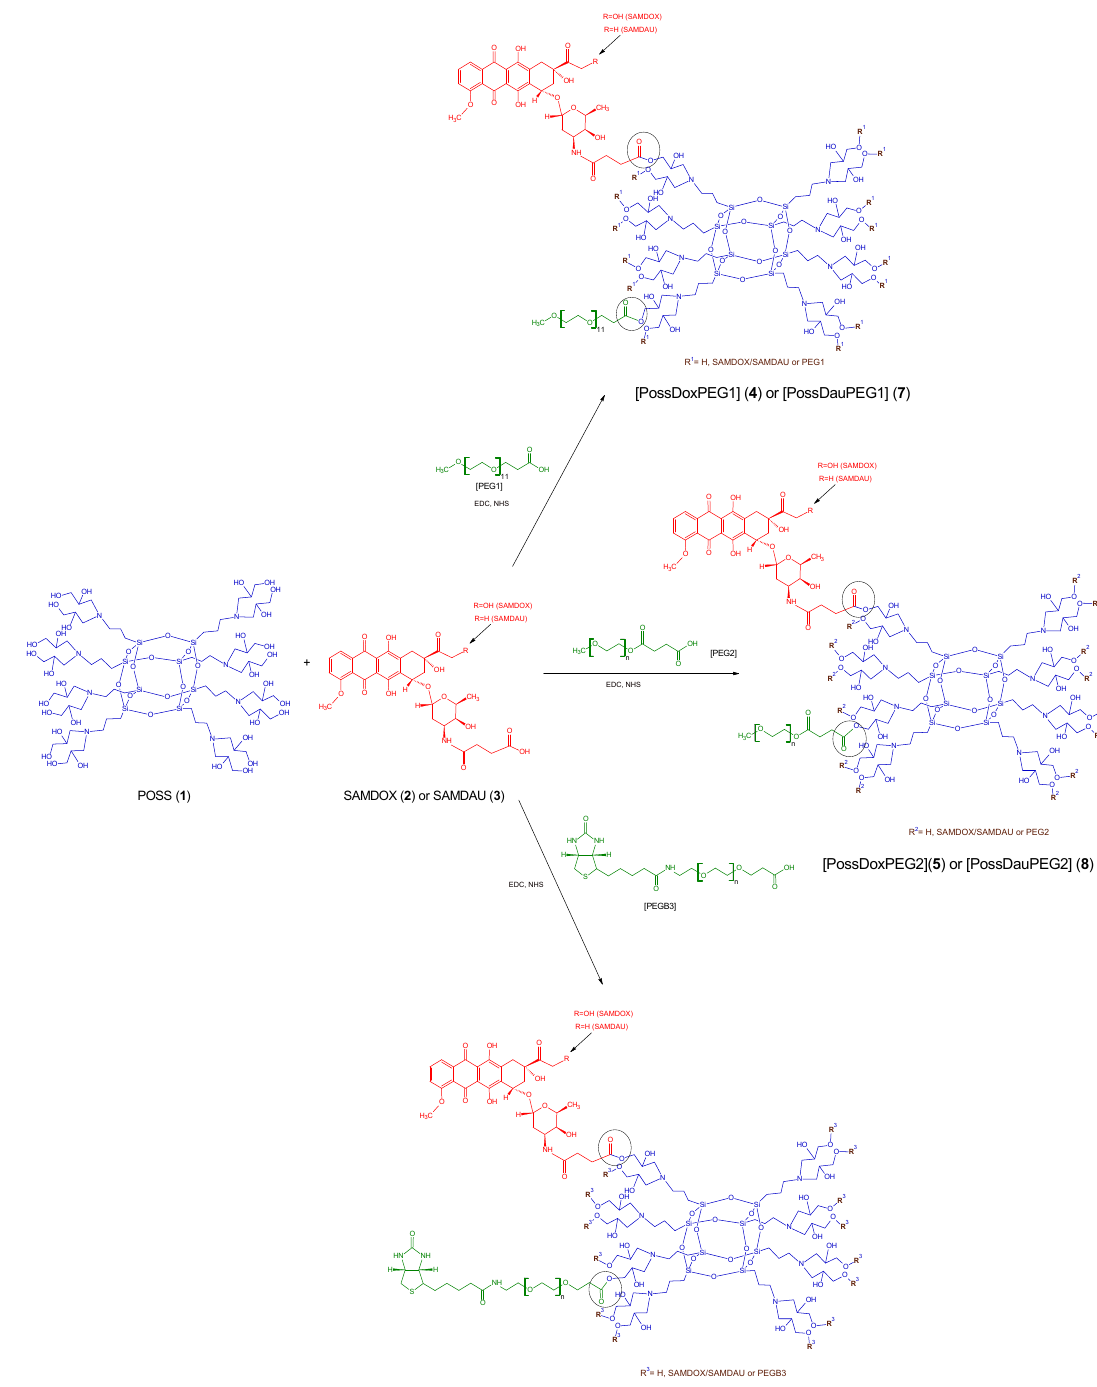
Figure 2. Synthesis of POSS conjugates 4 – 9 . PossDoxPEG1 ( 4 ): POSS conjugate containing doxorubicin and PEG1 [ O -(2- Carboxyethyl)- O ′ -methyl-undecaethylene glycol; M w 588.68), PossDoxPEG2 ( 5 ): POSS conjugate containing doxorubicin and PEG2 [ O -Methyl- O ′ -succinylpolyethylene glycol 2 ′ 000; M w ~2100], PossDoxPEGB3 ( 6 ): POSS conjugate containing doxorubicin and PEGB3 [ O -[2-(Biotinyl-amino)ethyl]- O ′ -(2-carboxyethyl)polyethylene glycol; M w 3000], PossDauPEG1 ( 7 ): POSS conjugate containing daunorubicin and PEG1, PossDauPEG2 ( 8 ): POSS conjugate containing daunorubicin and PEG2, PossDauPEGB3 ( 9 ): POSS conjugate containing daunorubicin and PEGB3.